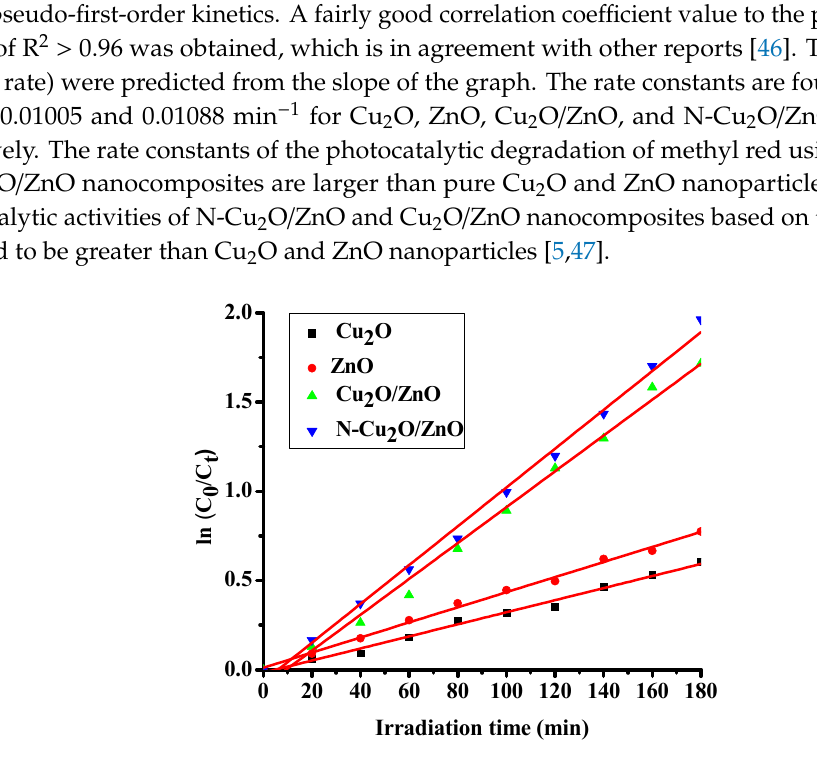
Figure 8. Reaction kinetics curve.